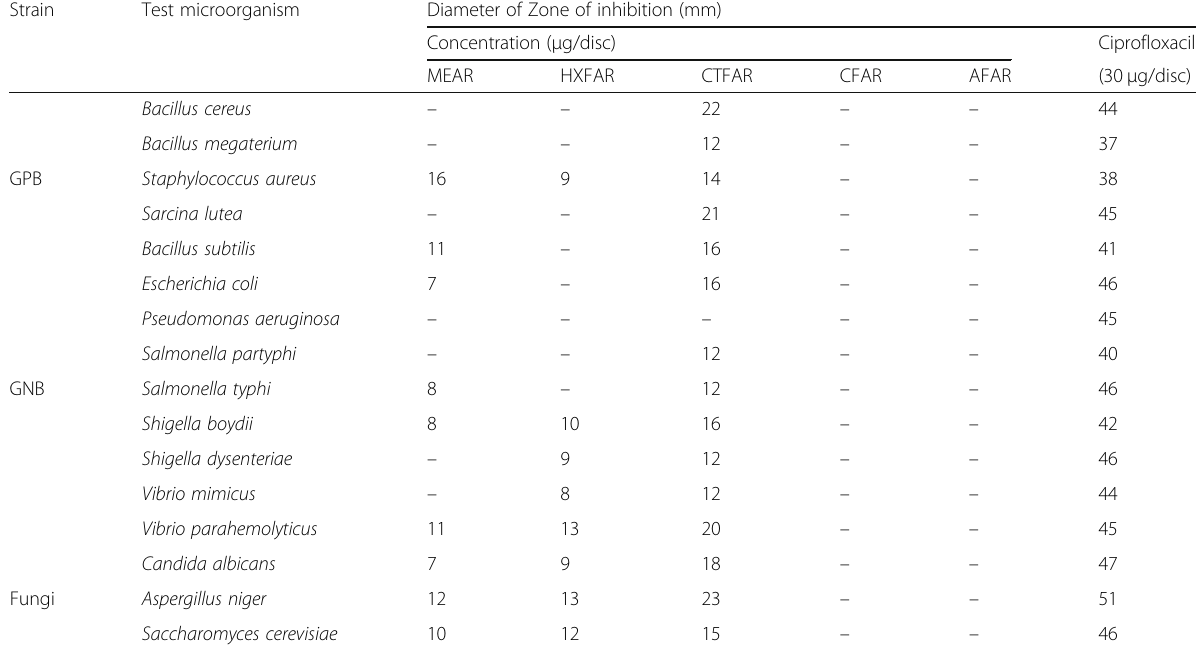
Table 4 Antimicrobial activity of test samples of Albizia richardiana Strain Test microorganism